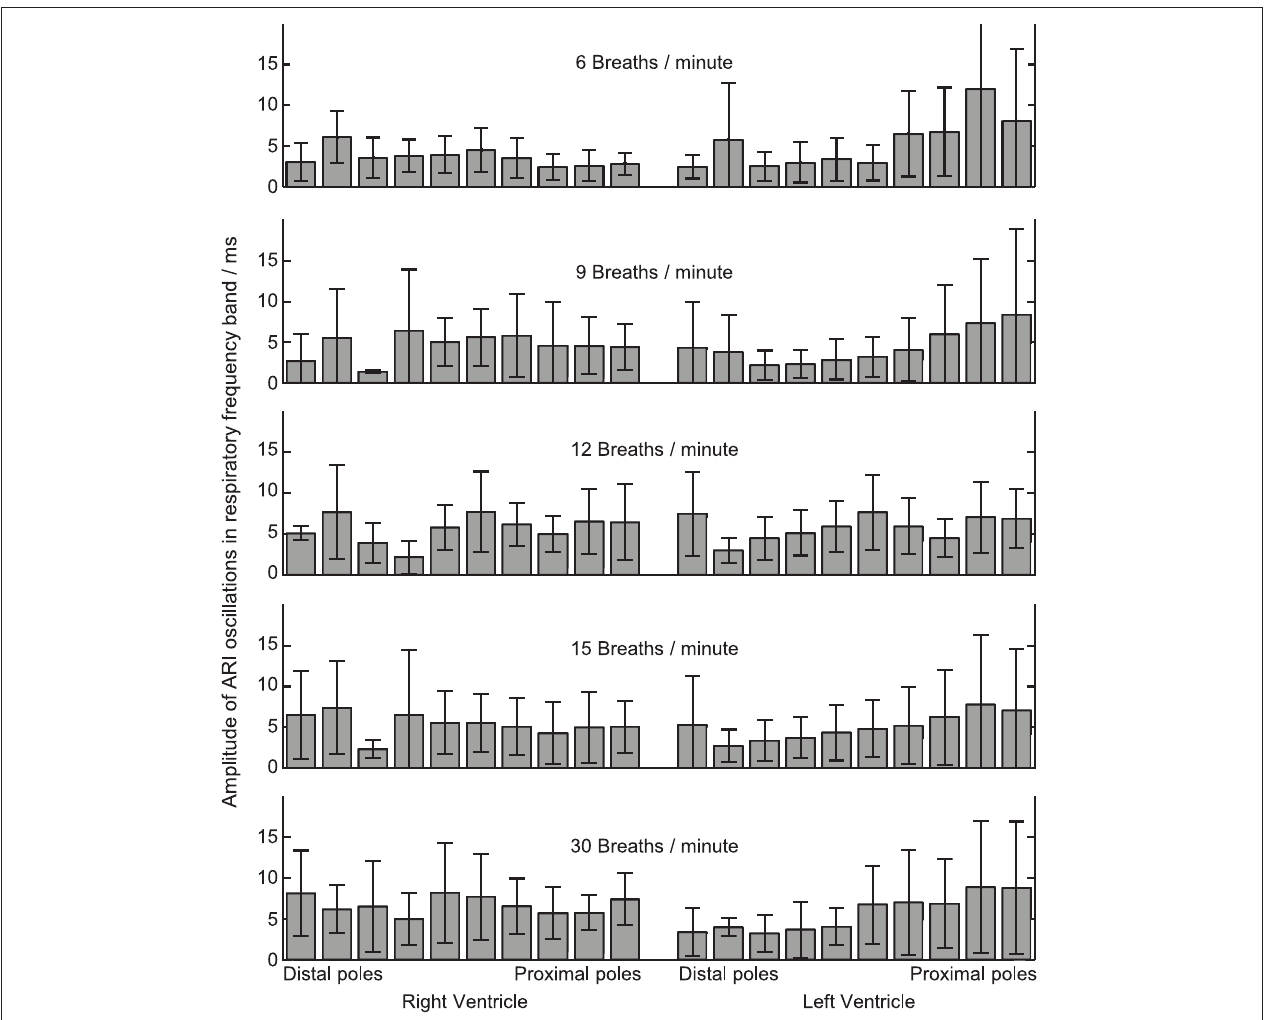
Figure 3 . At each respiratory rate, ARI oscillation was measured at 20 local recording sites on the left and right ventricular myocardium. 16 subjects studied: mean ± standard deviation